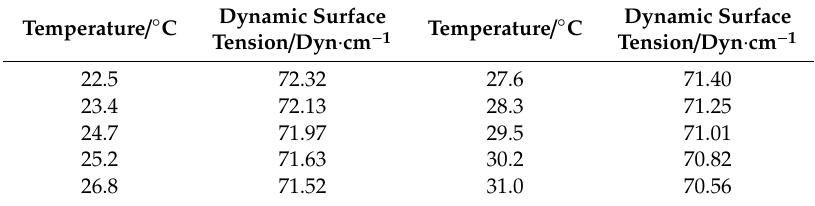
Table 2. Some dynamic surface tension (DST) values of di ff erent water temperatures.